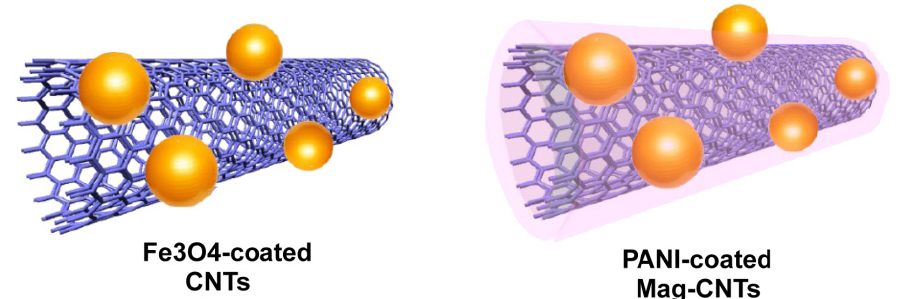
O -coated CNTs ( left ) and PANI/Fe 3 4